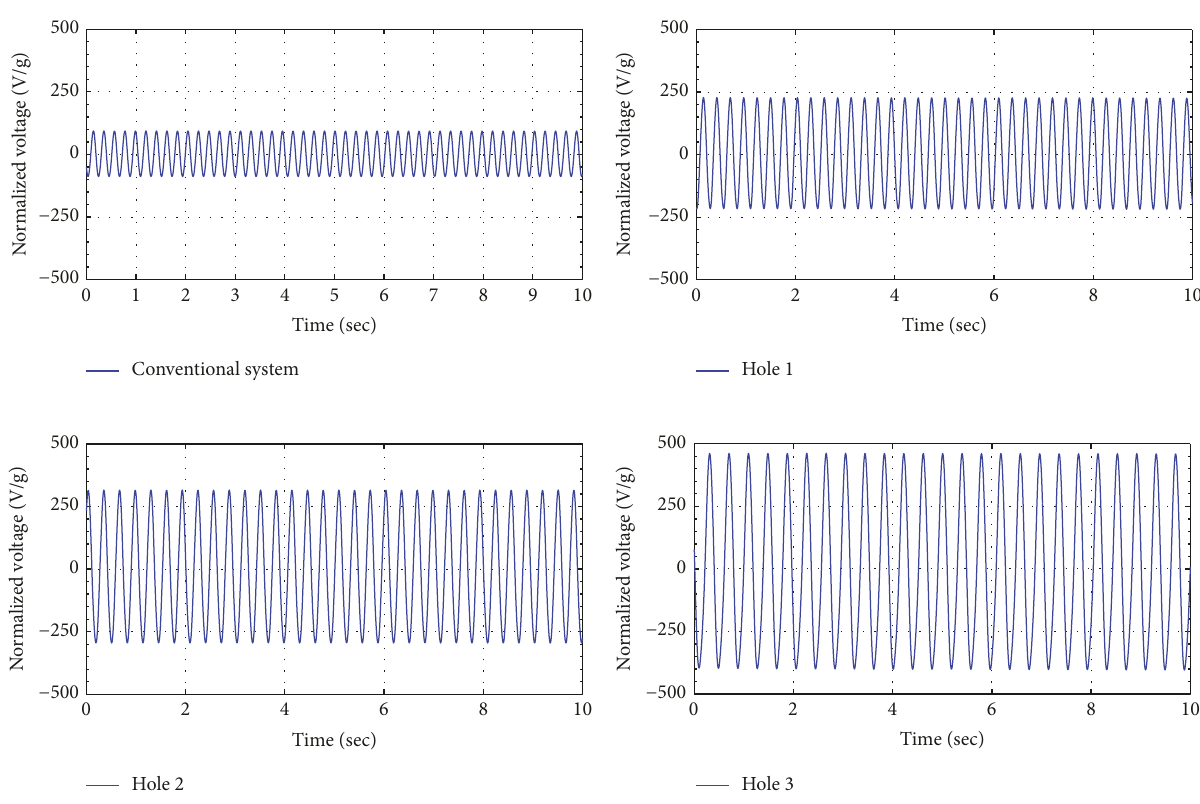
Figure 4: Time history responses for the resonant frequencies of each case.